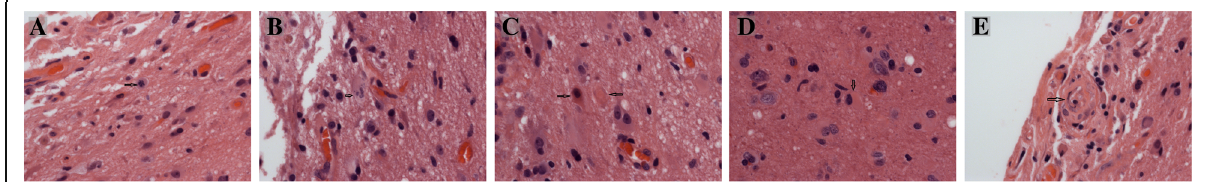
Fig. 4 Histologic analysis of laser-induced thermal therapy treated left temporal glioblastoma multiforme revealed showed some hallmark characteristics including a mitotic body ( a ) a multinucleated cell ( b ) axonal spheroid as well as an ischemic neuron ( c ) microglia and reactive gliosis ( d ) and an occluded blood vessel as well as thrombotic vascular changes ( e